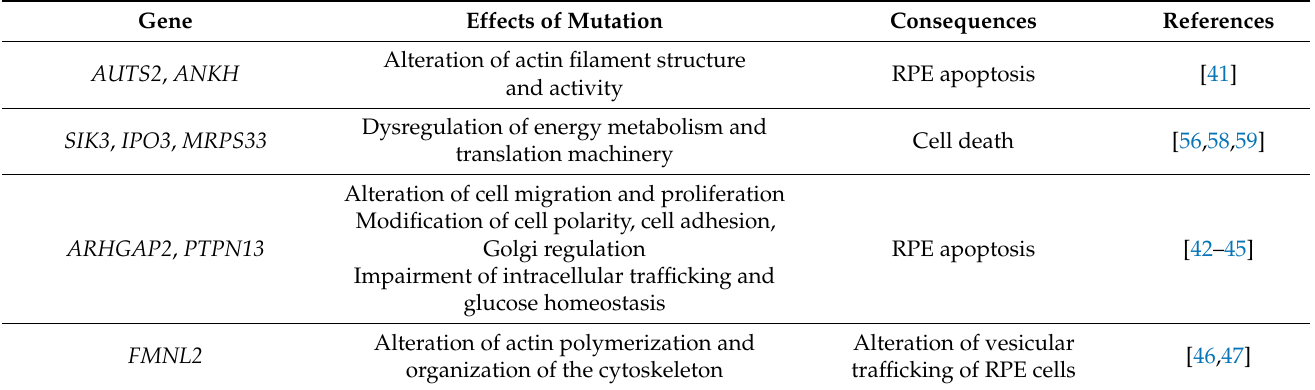
Table 2. GLO1 -related genes mutations: RPE dysfunction and photoreceptors damage.